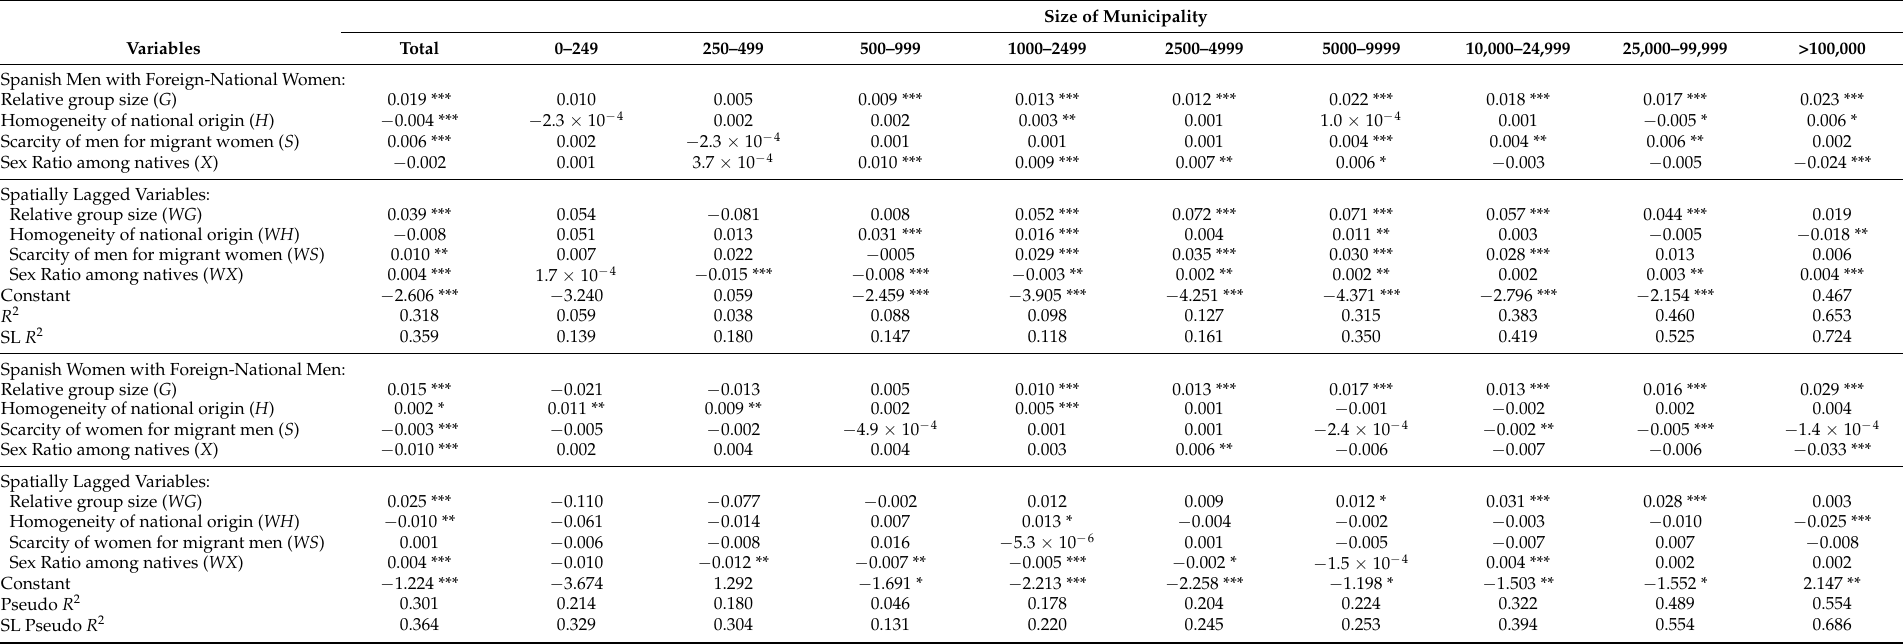
Table 4. Regression results for the intermarriage rate (probit model for grouped